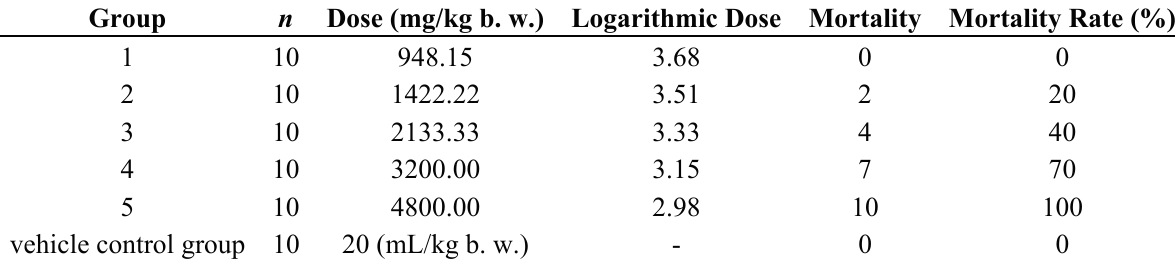
Table 2. Oral single-dose toxicity of ATTM in